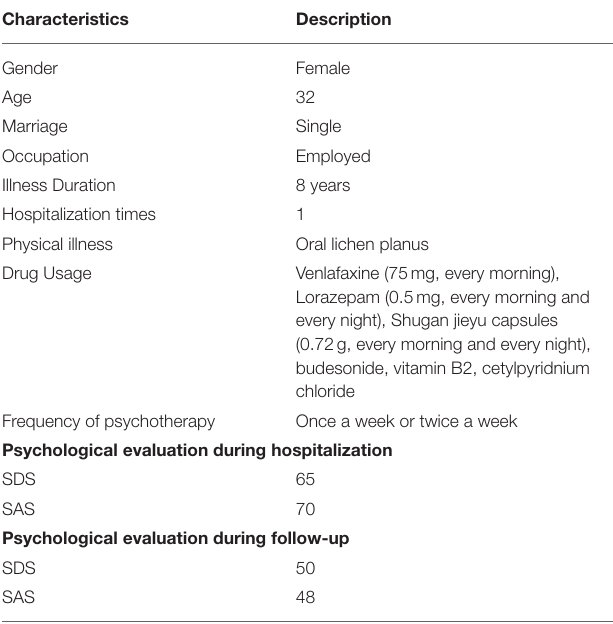
TABLE 1 | Patient’s demographic and clinical characteristics.